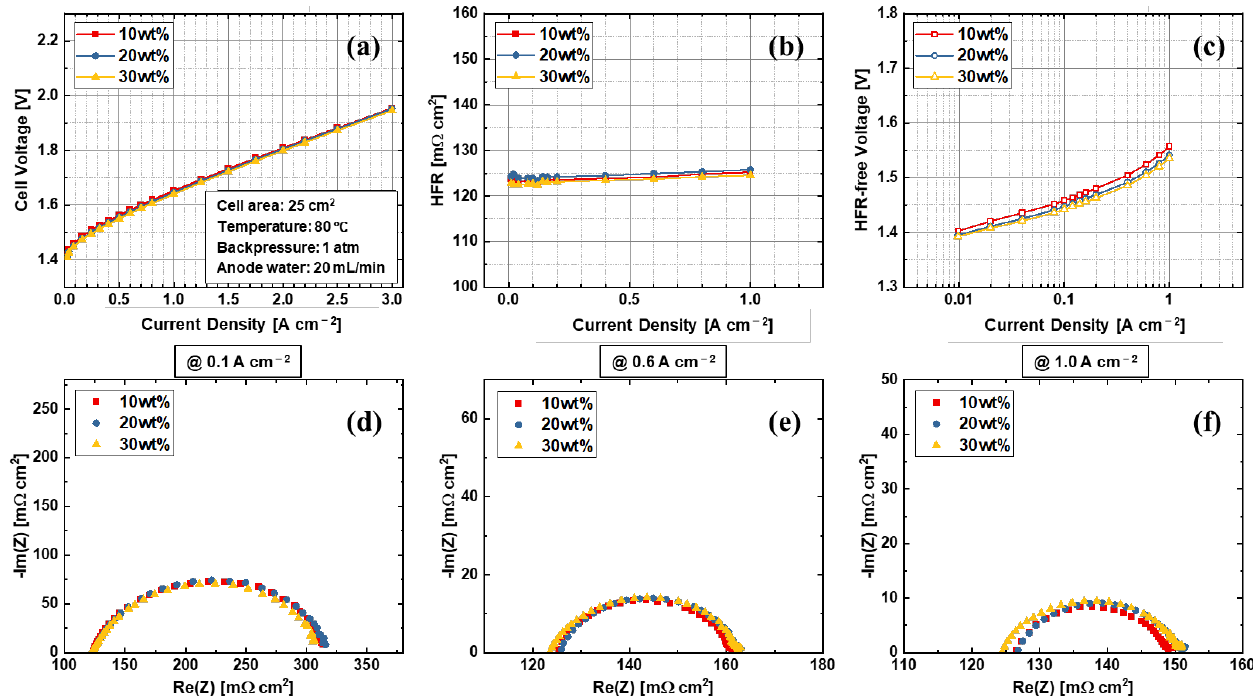
Figure 10. Effects of catalyst weight content in anode electrode ink. ( a ) Performance, ( b ) HFR, ( c ) Tafel slopes, and EIS at ( d ) 0.1 A cm −2 , ( e ) 0.6 A cm −2 , and ( f ) 1.0 A cm −2 .